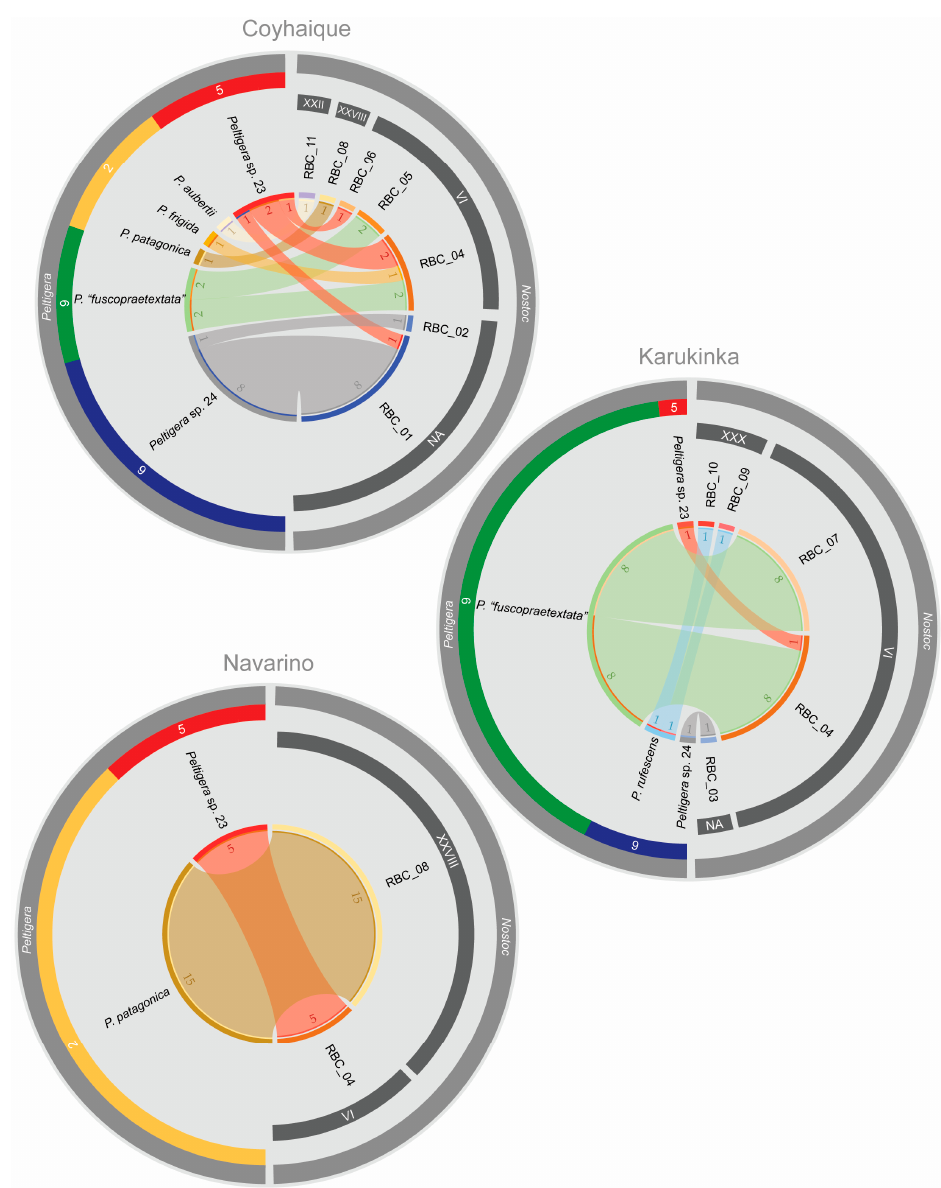
Figure 6. Symbiotic associations of mycobionts ( Peltigera species) and cyanobionts ( Nostoc haplotypes) in the three high Andean steppes plotted using Circos Table Viewer v0.63-10 [53] and edited in Adobe Illustrator. The width of the ribbons shows the abundance of the associated symbionts. The outer stripes indicate the identified symbionts ( Peltigera or Nostoc ), while the inner stripes indicate the Peltigera clades or Nostoc phylogroups.